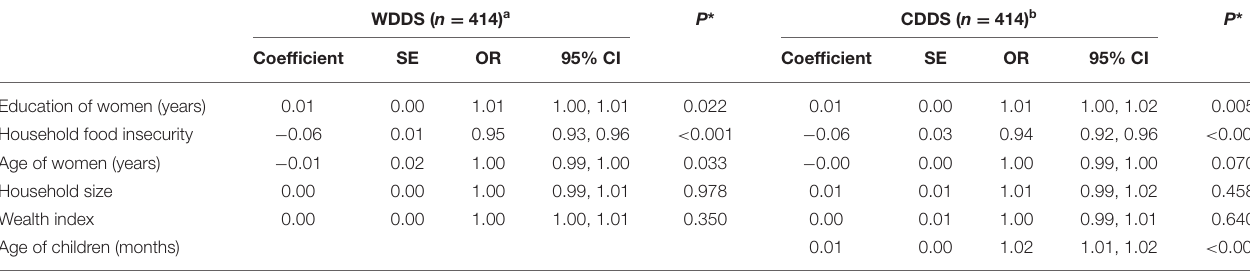
TABLE 7 | Factors associated with dietary diversity among women and children in Western Kenya ( n =